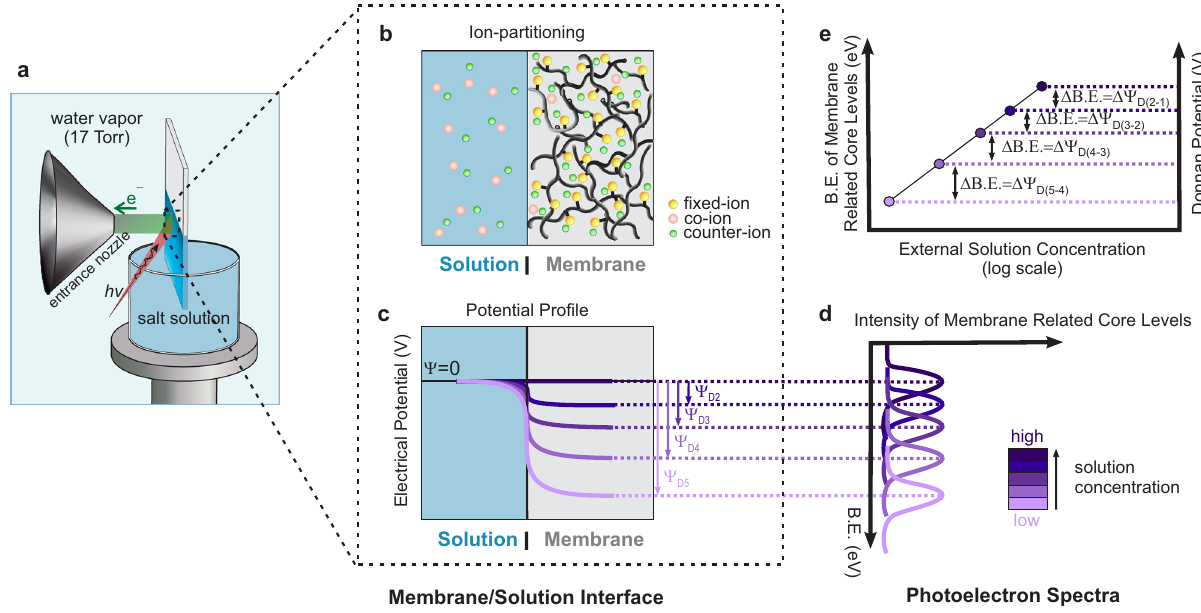
Fig.1|OverviewofdirectDonnanpotentialmeasurementusingtenderAPXPS. a A schematic of the experimental setup during data acquisition from the CR-61 membrane equilibrated in aqueous salt solution. b Equilibrium ion-partitioning between a membrane in contact with a monovalent electrolyte solution. At equi- librium, electroneutrality requires an equivalent number of counter-ions (which, foramonovalentsystem,isequaltothe fi xedchargeconcentration)tobalancethe fi xed charge groups. The co-ions sorbing into the membrane are accompanied by